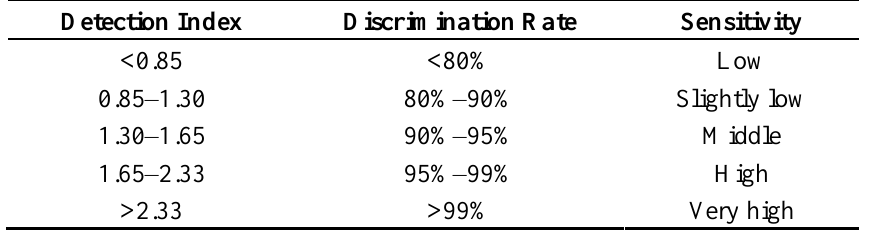
Table 2 lists the diagnosis sensitivity standard for condition diagnosis. Table 2. Diagnosis sensitivity for condition